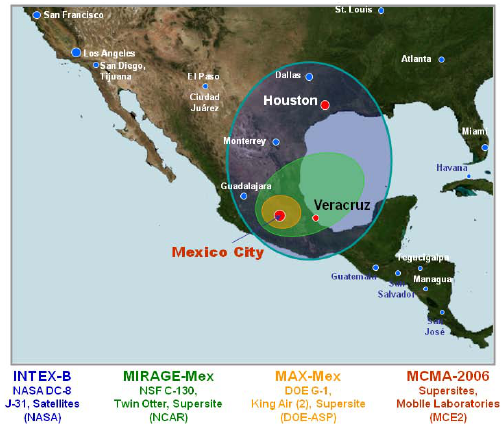
Fig. 2. Air quality trends of the MCMA. Plots show the concen- trations estimated as the average of the 5th annual maximum from all stations with valid data for a given year for the following criteria pollutants: O 3 , NO 2 , CO, SO 2 , Pb (divided by 10), TSP (Total Sus- pended Particles), PM 10 and PM 2 . 5 . (Data provided by SMA-GDF, 2009).